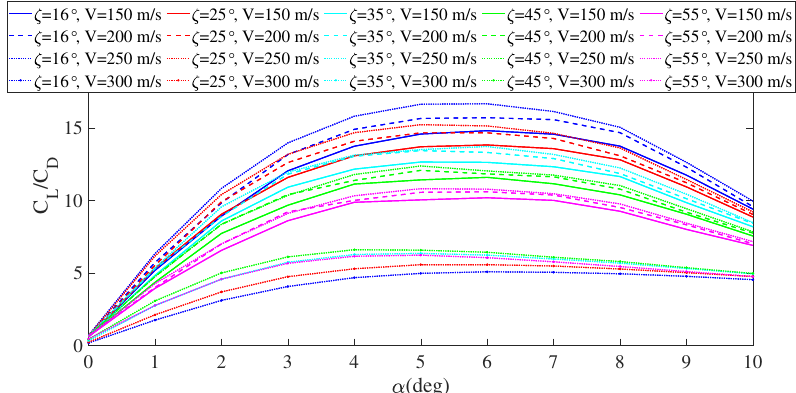
Figure 6. The lift-to-drag ratios C L / C D for different conditions of V and ζ under h = 7000 m.